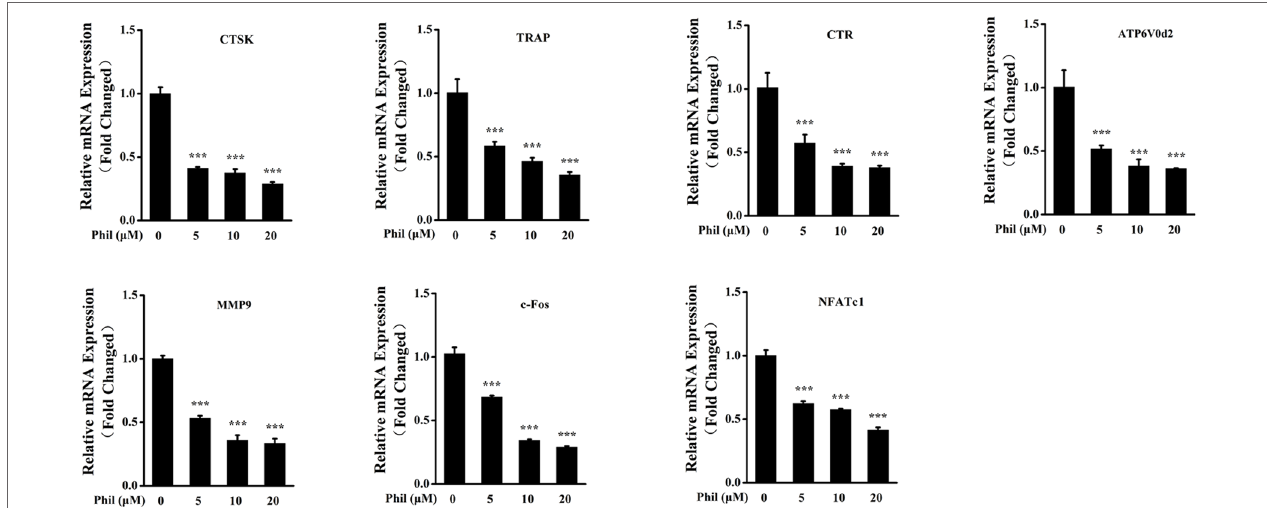
FIGURE 4 | Phil decreases the transcript levels of RANKL-stimulated osteoclastic marker genes. BMM cells were cotreated with different doses of Phil in the presence of RANKL (100 ng/ml) and M-CSF (30 ng/ml) for 5 days. Real-time PCR was then performed to examine the transcripts of osteoclastic marker genes. The mRNA levels of these genes were normalized to GAPDH (n = 3). *** P < 0.001 relative to RANKL-induced, Phil-untreated group. CTSK, cathepsin K; TRAP, tartrate- resistant acid phosphatase; CTR, calcitonin receptor; ATP6V0d2, ATPase H + transporting V0 subunit d2; MMP9, matrix metallopeptidase 9; NFATc1, nuclear factor